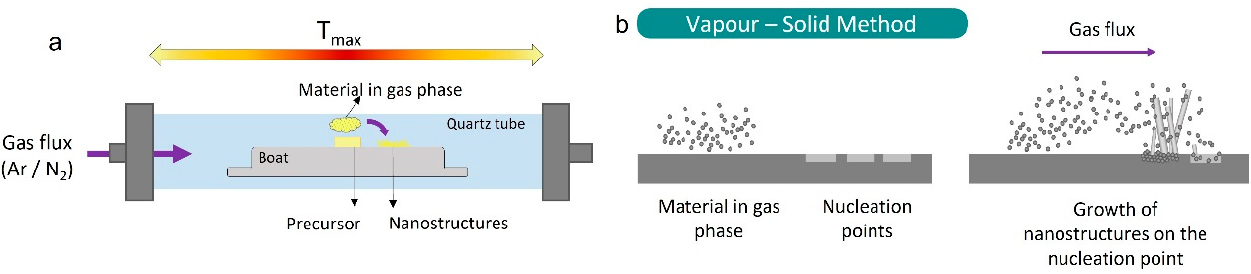
Figure 1. Scheme of the tubular furnace ( a ) and schematic drawing of the Vapor–Solid process ( b ). Morphological characterization was carried out by Secondary Electron (SE) mode in an FEI Inspect Scanning Electron Microscope (SEM, Lincoln, NE, USA). Cathodoluminscence (CL) and Energy Dispersive X-Ray (EDX) experiments were performed in a Leica 440 SEM (Wetzlar, Germany). CL images were recorded using a Hamamatsu R928 photomultiplier (Shizuoka ken, Japan) and CL spectra by means of a Hamamtsu PMA-11 charge